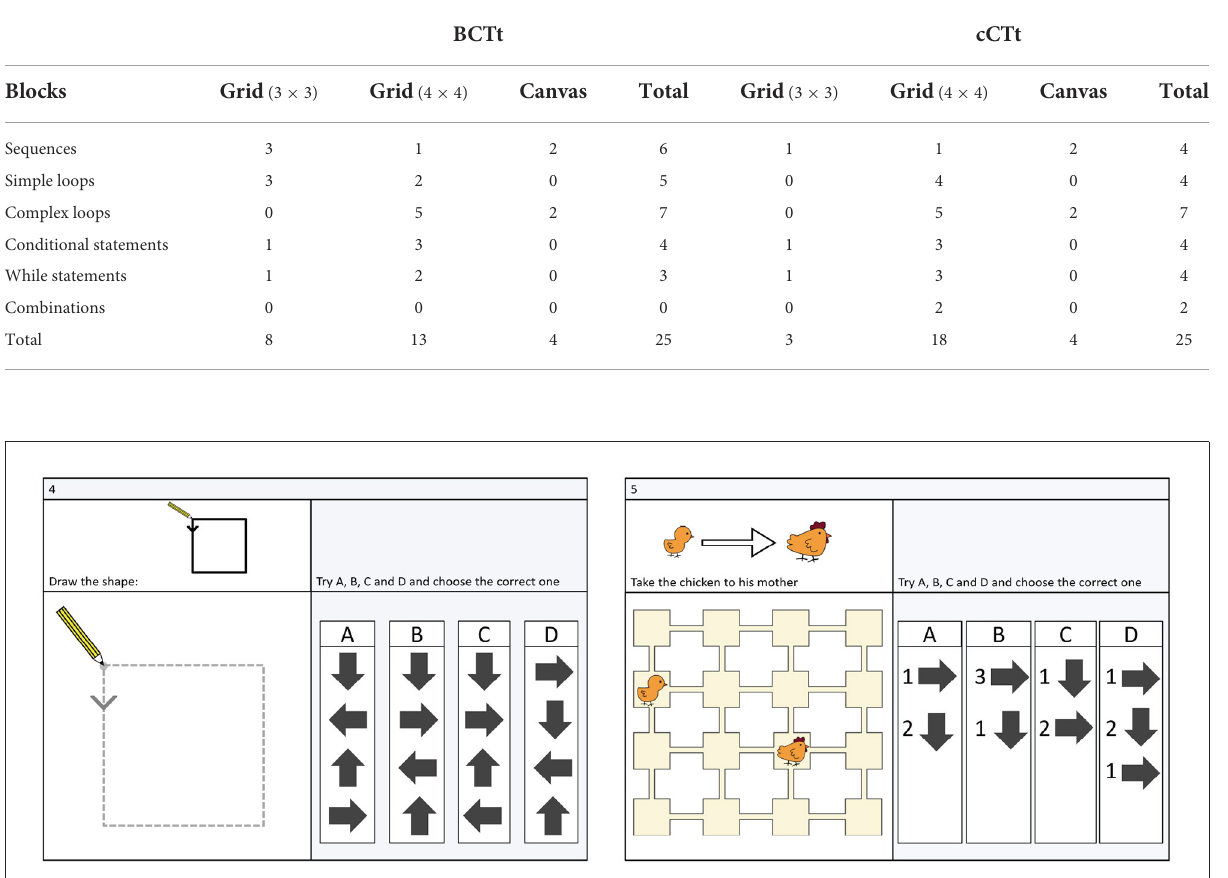
TABLE 2 Comparison between the BCTt and the cCTt in terms of question concepts and question types (Table taken from El-Hamamsy et al., 2022a).